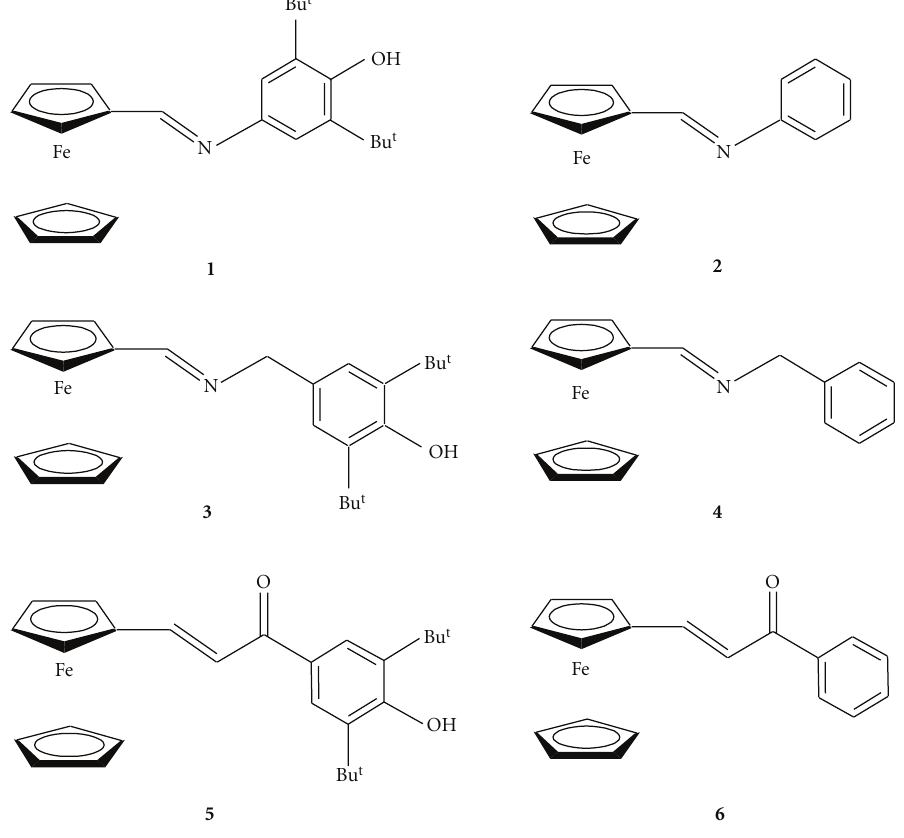
Figure 1: Structures of compounds 1 – 6